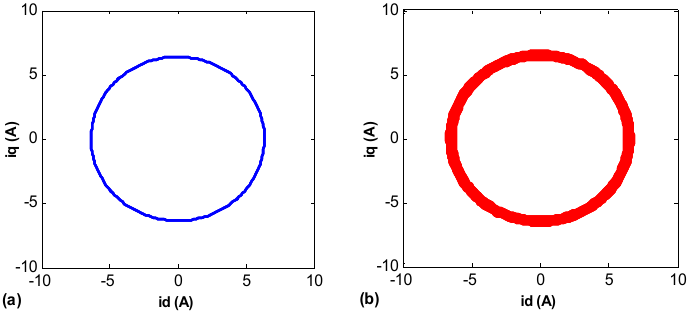
Figure 3. Park’s vector trajectories: ( a ) healthy motor and ( b ) motor with simulated BRB.